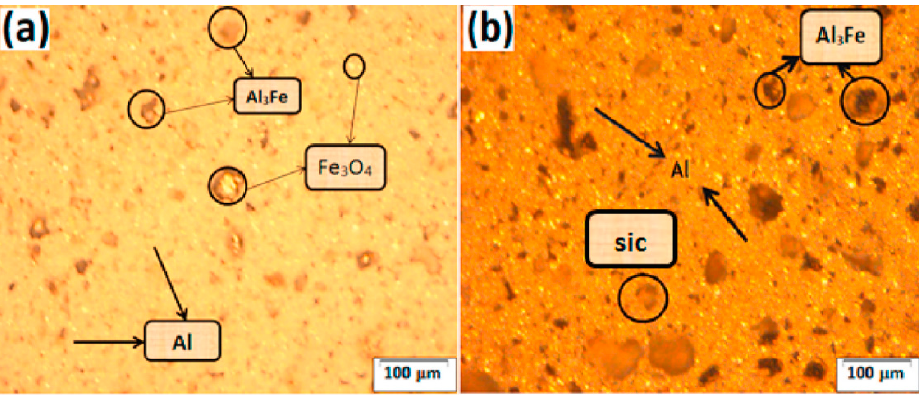
Figure 4. Optical microscopy of ( a ) Al–15 Fe 3 O 4 and ( b ) Al–15 Fe 3 O 4 –30SiC [22].